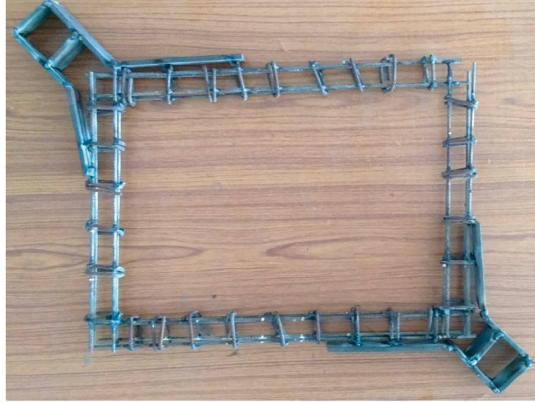
Figure 2: Reinforcement details of the frame.